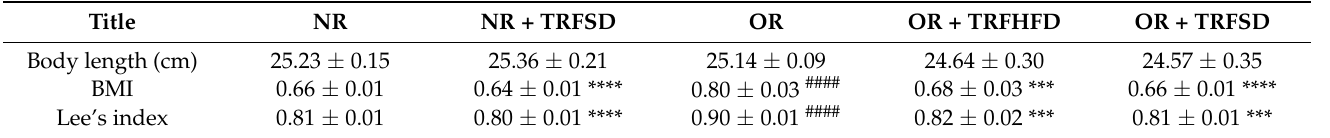
Table 3. Effect of intermittent fasting on BMI and Lee’s index in normal and obese rats.